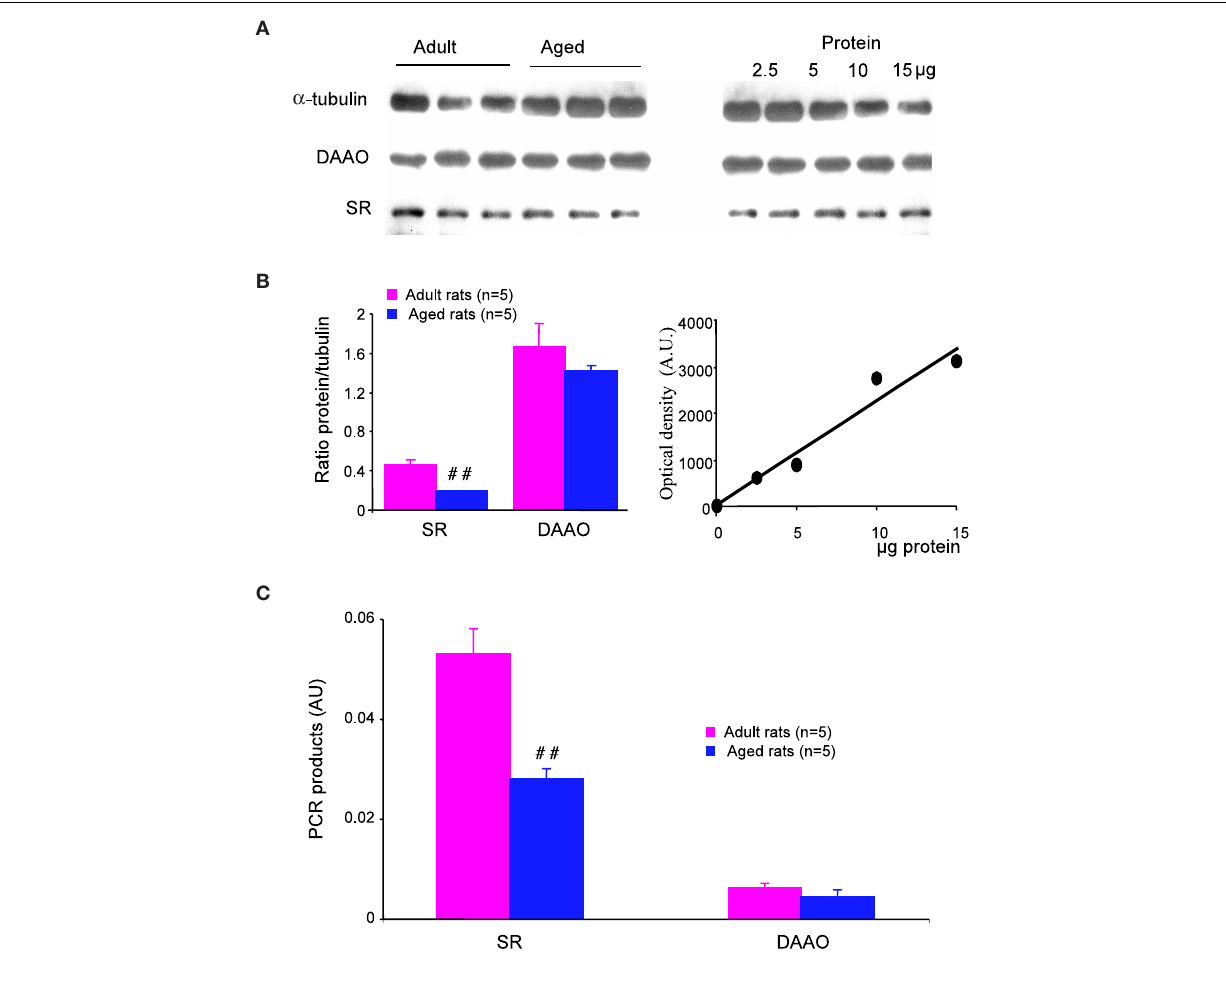
FIGURE 5 | Serine racemase expression is reduced in aged rats. ( A , left) Immunoblots for α -tubulin (upper band), D AAO (middle band) and serine racemase (lower band) in adult and aged rats. 10 µg of protein were loaded per lane. ( B , right) Immunoblots obtained with different amounts of protein loaded (2.5–15 µg/lane) in order to evaluate relative optical density variations. ( B , left)